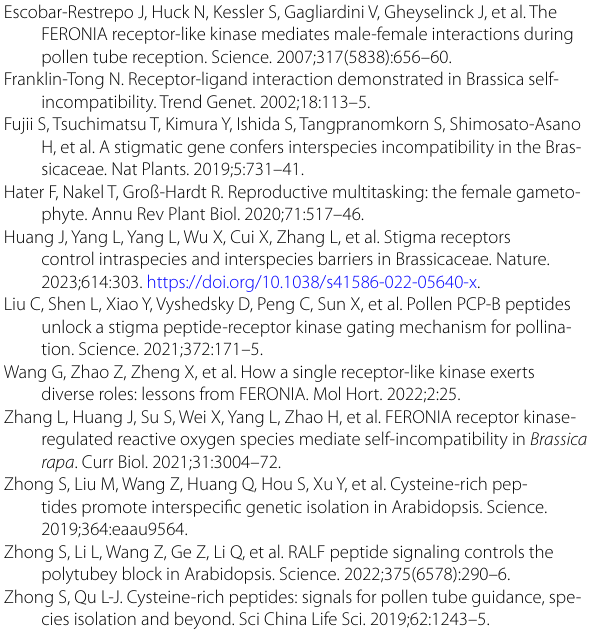
reproduction. As reported previously, there are additional pre-zygotic reproductive barriers during pollen-pistil inter- action in SC plants (Zhong and Qu 2019; Hater et al. 2020), such as pollen tube guidance (Zhong et al. 2019) and pollen tube reception (Escobar-Restrepo et al. 2007; Zhong et al. 2022). Given the limited understanding of interspecific/ intergeneric isolation, dissecting the molecular mechanisms of other pre-zygotic/post-zygotic interspecific/intergeneric barriers would lay the foundation for distant hybridization of crops to secure food production for humans in the